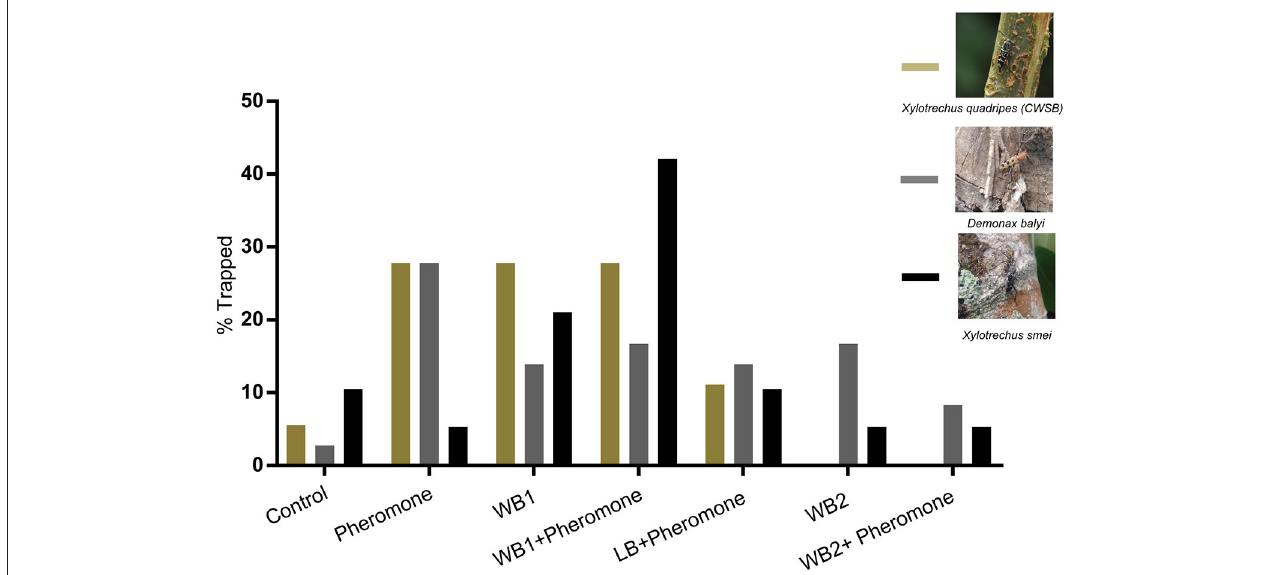
FIGURE 5 | CWSB attraction toward host volatile blends in field conditions. Percentage of longhorn beetles Xylotrechus quadripes (CWSB; n = 18, Olive green), Xylotrechus smei ( n = 19, Black), and Demonax balyi ( n = 36, Dark gray) trapped in black panel traps with volatiles. See Supplementary Table 1 for statistical details. Wood blend 1 (WB1): blend of ( ± )- α -pinene, (–)- β -pinene, and (E)- β -caryophyllene. Wood Blend 2 (WB2): blend of ( ± )- α -pinene, (–)- β -pinene, (E)- β -caryophyllene, and ( R )-( + )-limonene. Leaf Blend (LB): blend of (E)- 2-hexenal, (E)- 2-hexen-1-ol, (Z)- 3-hexen-1-ol, and ( ±